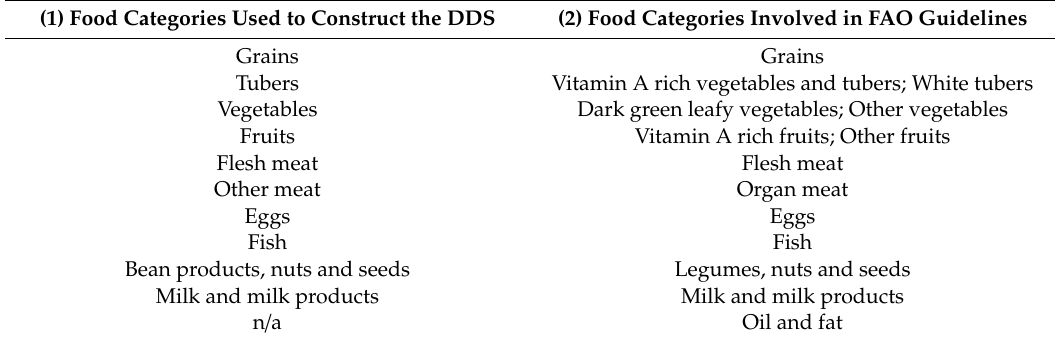
Table 1. Food categories used in the construction of dietary diversity scores